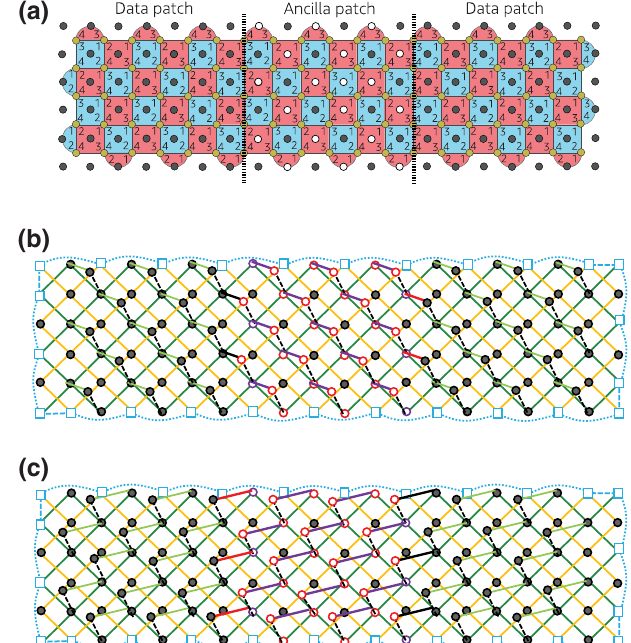
FIG. 18. (a) A surface-code lattice with d x = 5, d z = 7. The numbers in each stabilizer measurement plaquettes indicate the gate scheduling of the two-qubit gates (which in our simulations are CNOT gates). (b) The first type of space-time correlated edges for X stabilizers. (c) The second type of space-time correlated edges for X stabilizers. Space-time correlated edges incident to vertices present in the routing space are assigned different colors other than green for the reasons described in the